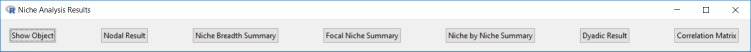
Niche analysis results.